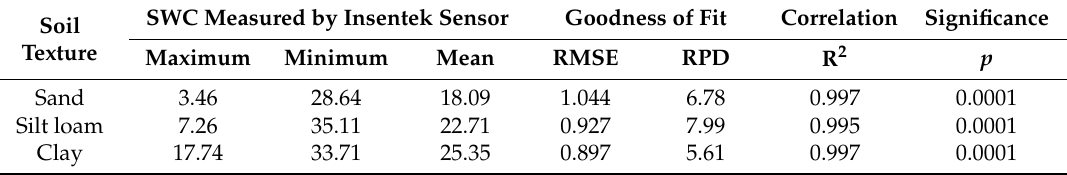
Figure 1. Insentek sensor and design of lysimeter experiment. ( a ) The structure and principle of an Insentek sensor; ( b ) lysimeter setup details and installation of an Insentek sensor. Table 1. Test for goodness of fit between soil water content (soil water content (SWC), cm 3 ·cm –3 ) measured using an Insentek sensor and oven-dry method across different soil textures.